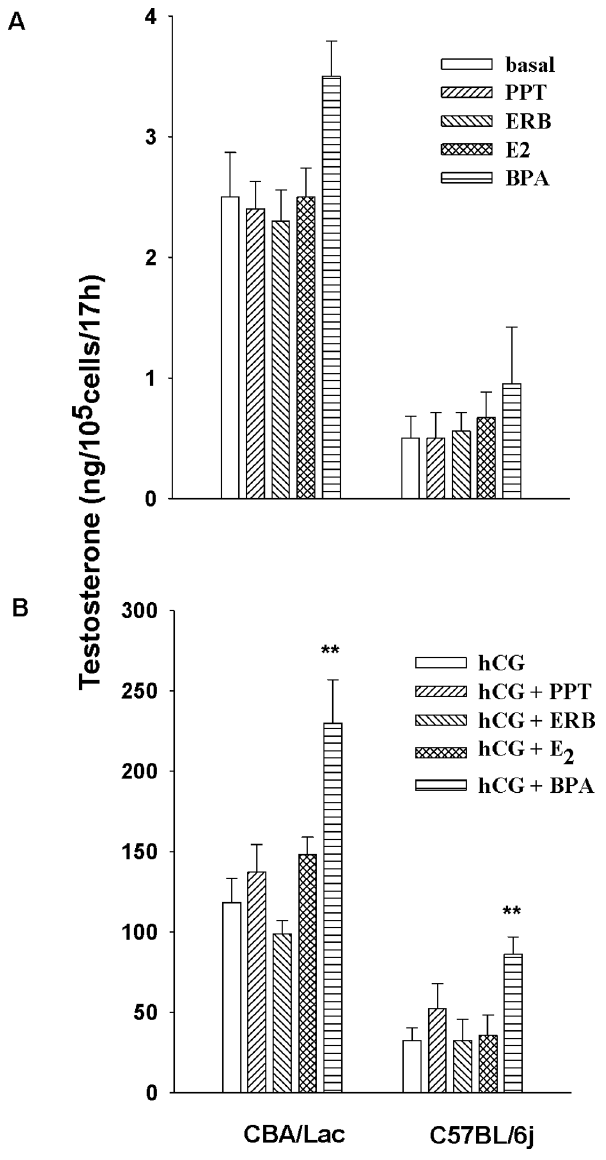
Figure 5. The effect of agonists of estrogen receptors and xenoestrogen BPA on basal and hCG-stimulated testosterone production by Leydig cells from C57BL/6j and CBA/Lac mice. Leydig cells were incubated with the agonists alone (A) or co-treated with hCG for 17 h (B). Each experiment was performed independently five times with similar results. **P , 0.01 compared to hCG treatment.